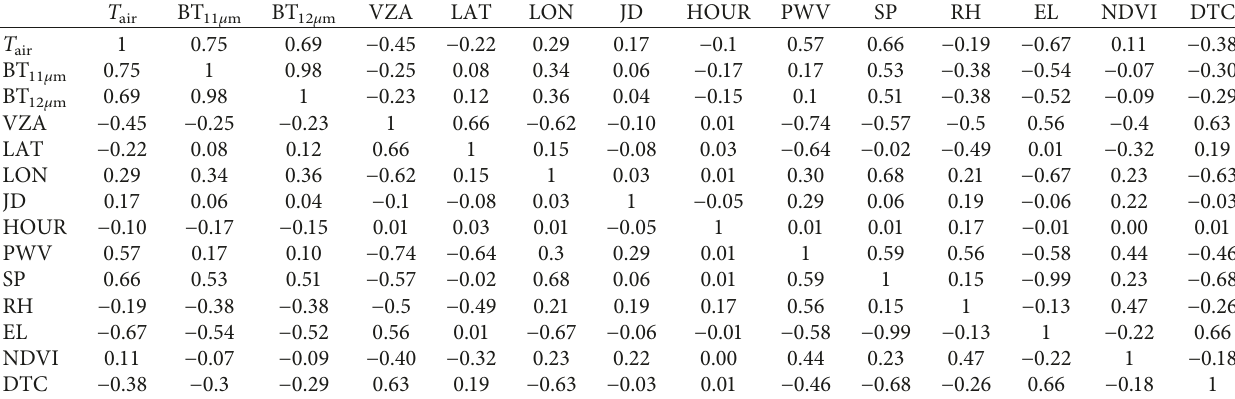
Table 3: Pearson’s correlation matrix of variables considered for the T